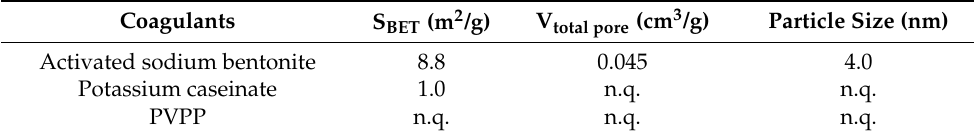
Table 4. Specific surface areas and pore characteristics of coagulants (n.q. — not quantifiable).